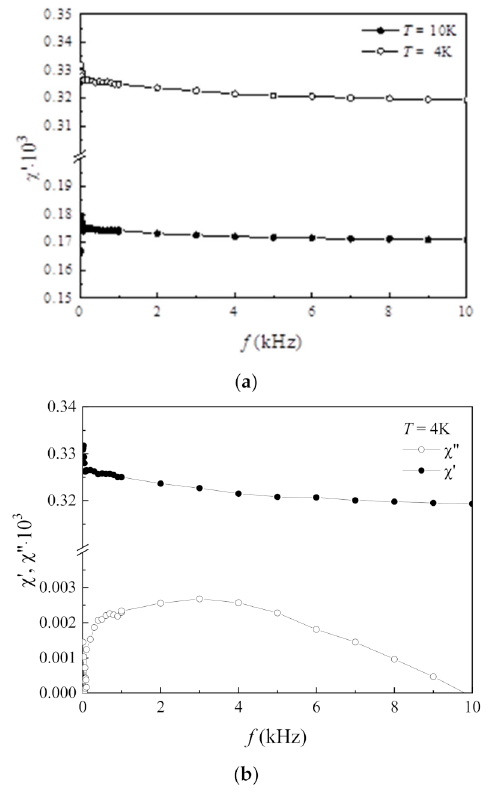
Figure 6. Frequency dependences of the AC susceptibility for the composite: ( a ) measurement of the real part of the susceptibility at 4 and 10 K; ( b ) measurement of the real and imaginary parts of the susceptibility at 4